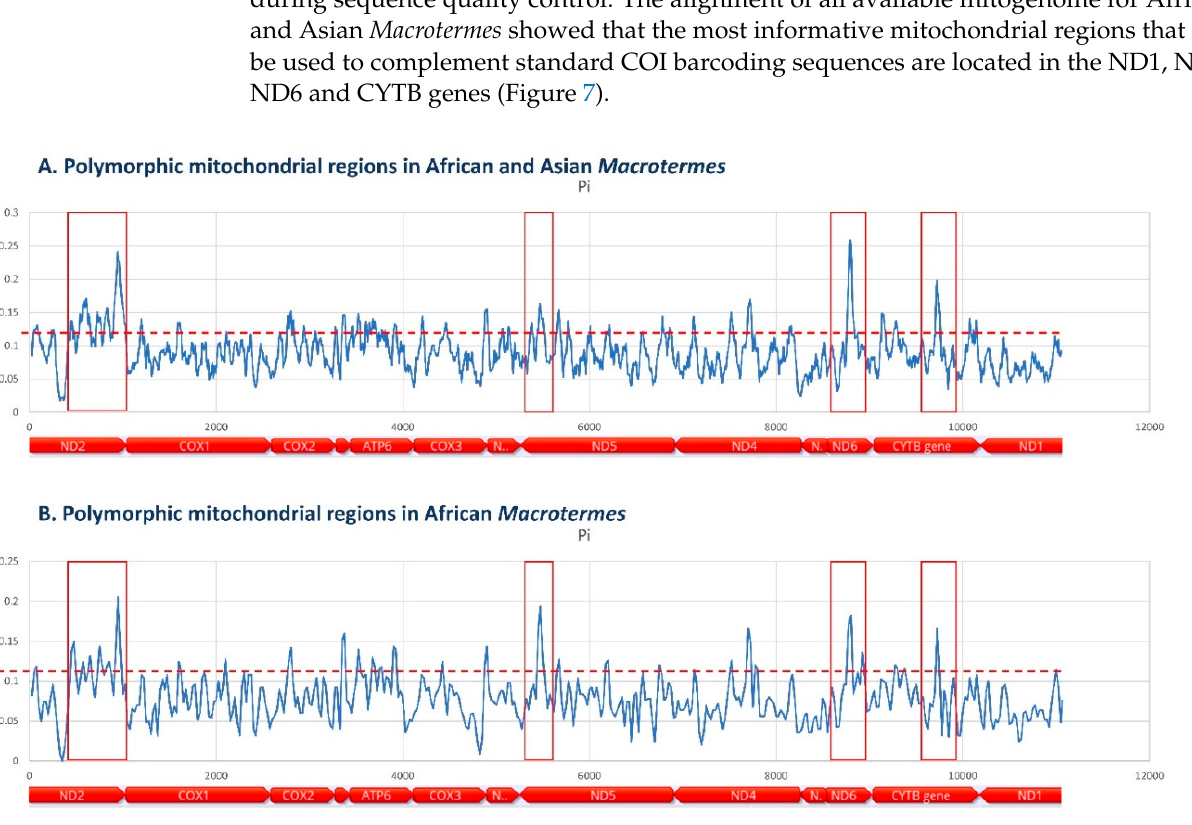
Figure 7. Polymorphic regions with potential utility as genetic markers for phylogenetic and species diversity studies in Macrotermes identified in the alignments of mitochondrial genomes of ( A ) African ( n = 5) and ( B ) African and Asian species ( n = 12).